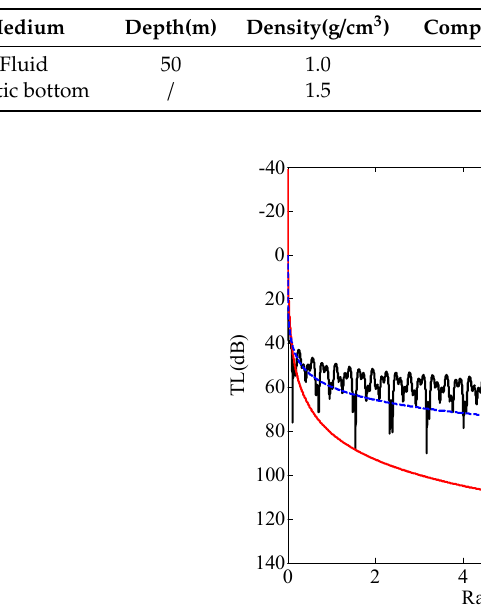
Table 1. Parameters of the ocean environment.